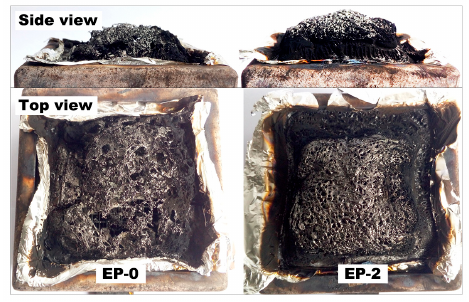
Figure 9. Digital photos of the char residue of EP-0 and EP-2 after cone calorimeter test.